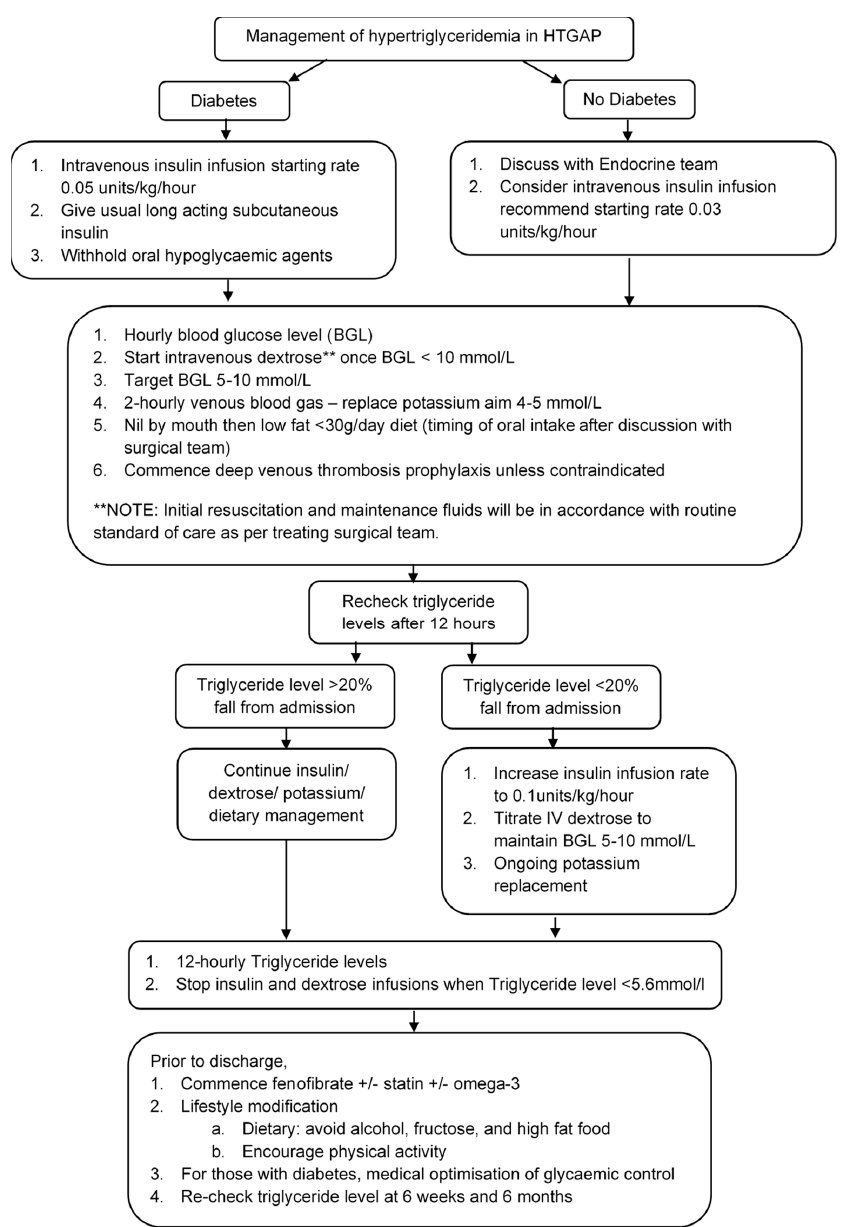
Figure A1. Proposed treatment algorithm for the management of hypertriglyceridemia in hypertriglyceridemia-associated acute pancreatitis (HTGAP). Administration of intravenous insulin infusion must be accompanied by close monitoring of patient clinical and biochemical parameters.